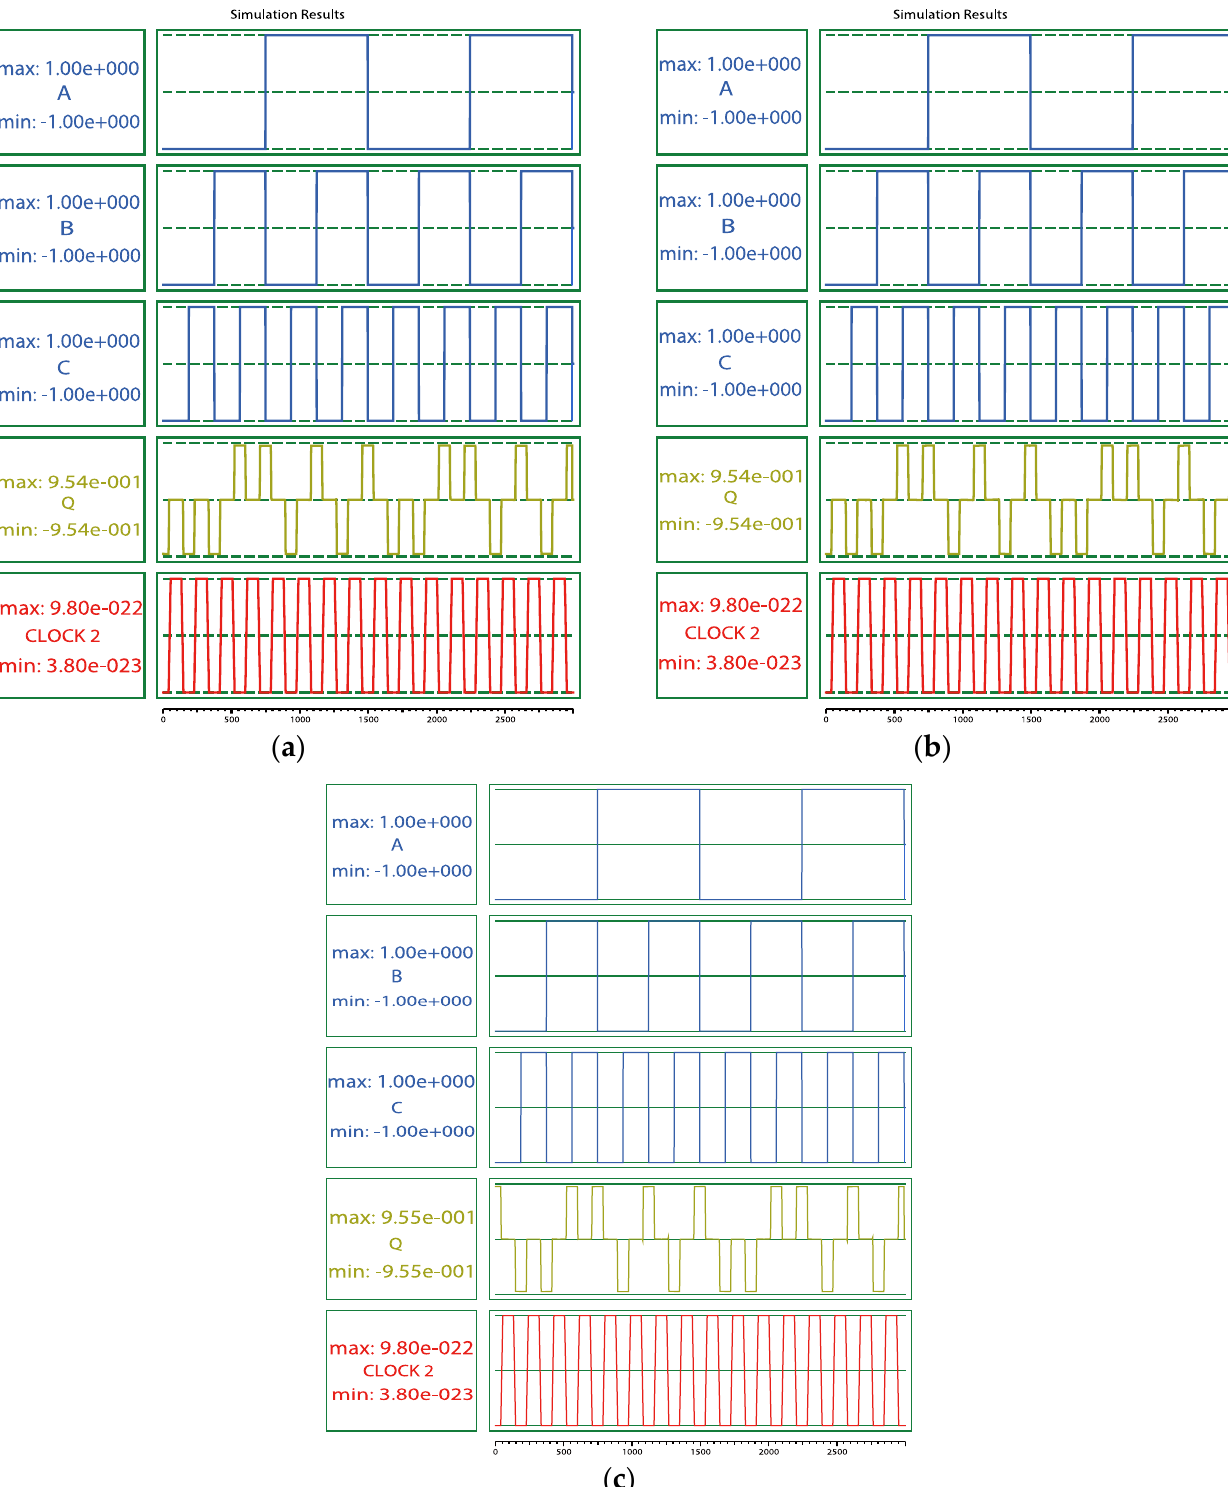
Figure 14. Layouts of the proposed 2-to-1 multiplexers: ( a ) 2-to-1 MUX1, ( b ) 2-to-1 MUX2, and ( c ) 2-to-1 MUX3 implemented by using the XOR in [5].